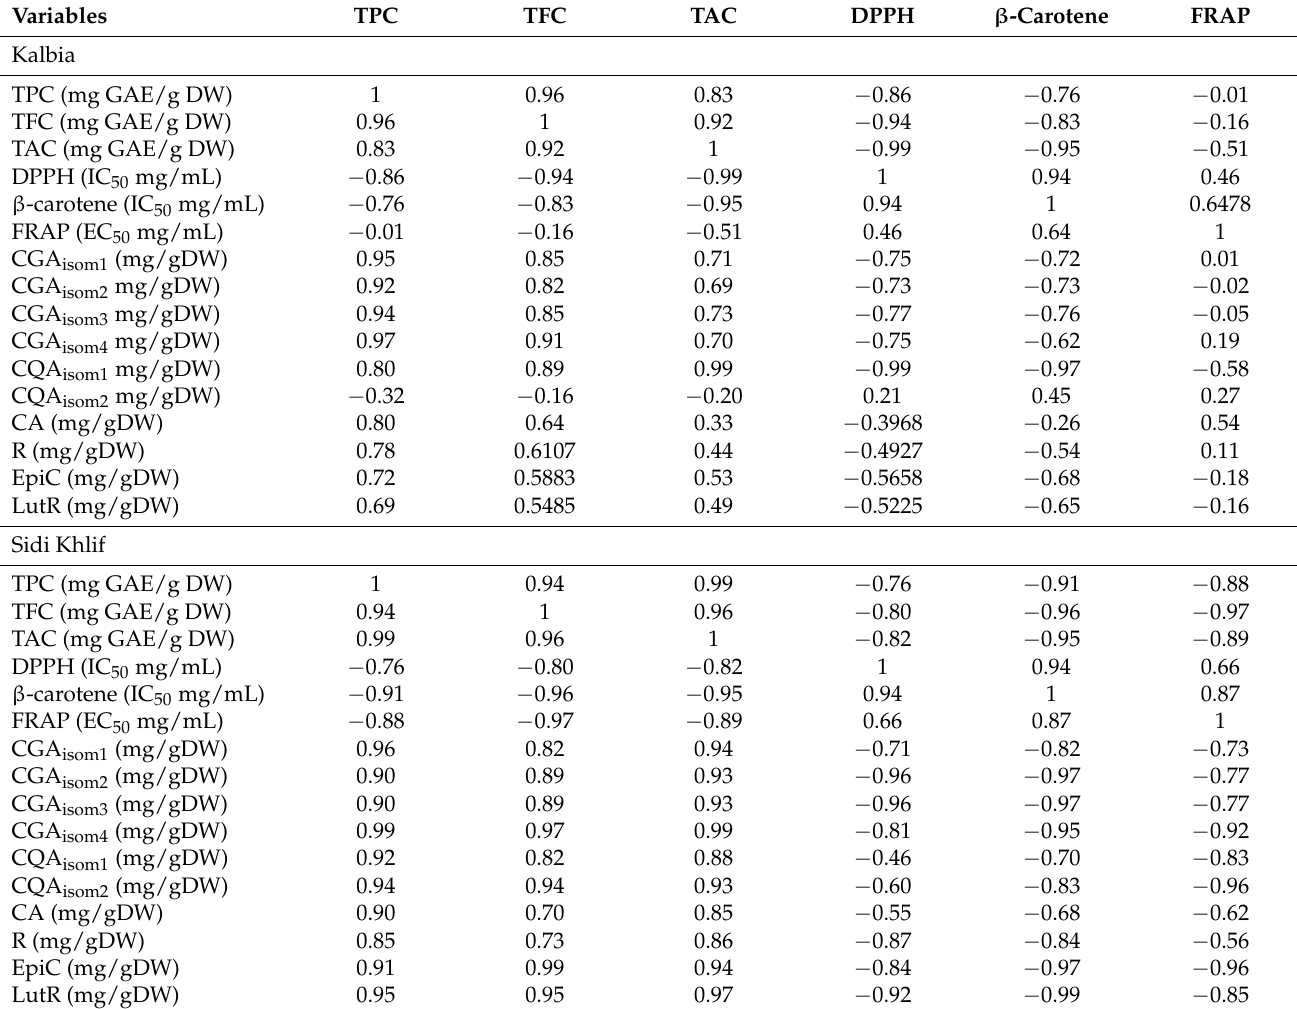
Table 7. Correlation coefficients between total and individual phenolic compound amounts and antioxidant